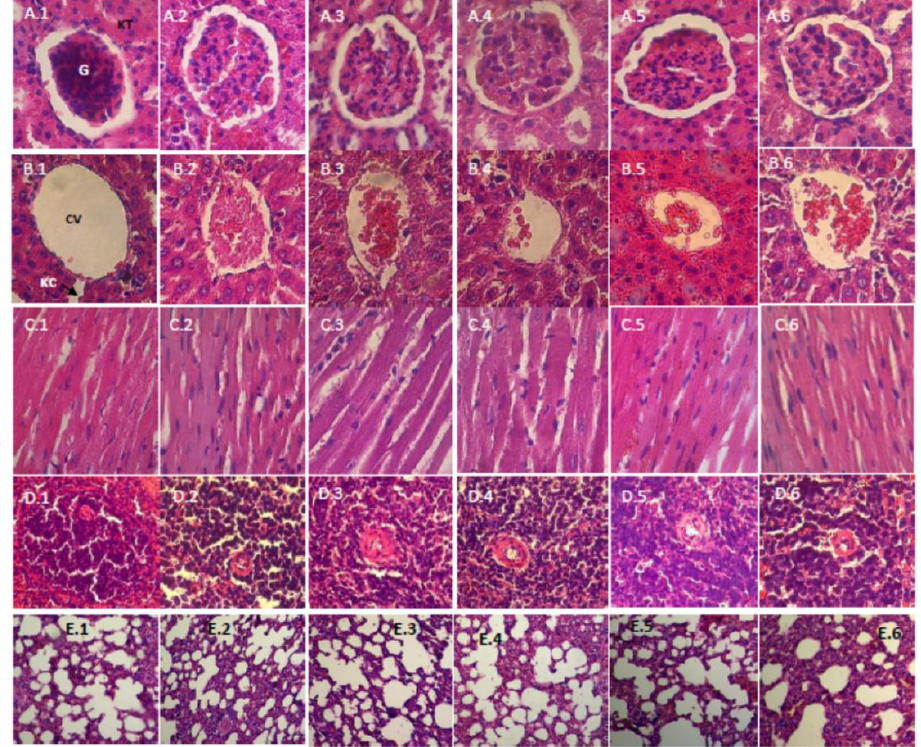
Figure 1. Histopathological examination (HE, 400 × ) of various organs of male rats in a subchronic oral toxicity study: ( A – E ) the kidney, liver, heart, spleen and lung, respectively; and (1–6) the control, satellite-control, the low, middle, and high dose groups, and the satellite-highest dose group (75 mg/kg bw), respectively. G, Glomerulus; KT, Kidney Tubules; CV, Central Vein; KC, Kupffer Cell.